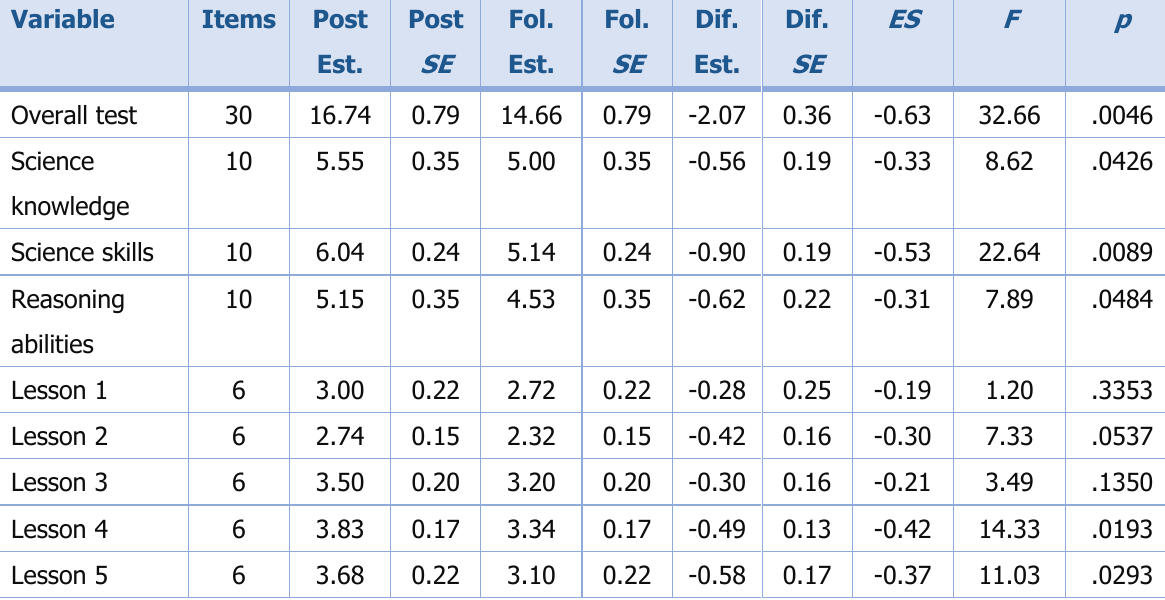
Table 1. Summary of Model-Based Estimates and Inferences for Objectives